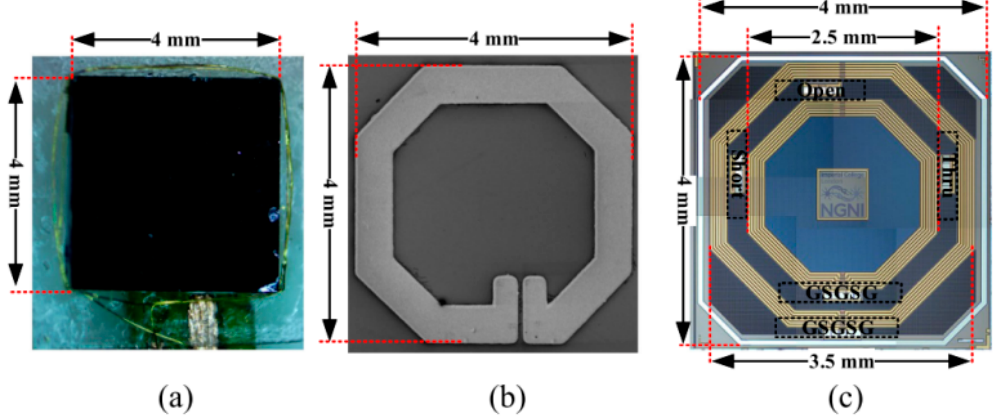
Figure 11. Chip-scale RX coils [40]. ( a ) around-CMOS. ( b ) above-CMOS. ( c ) in-CMOS. Copyright © 2018, IEEE.